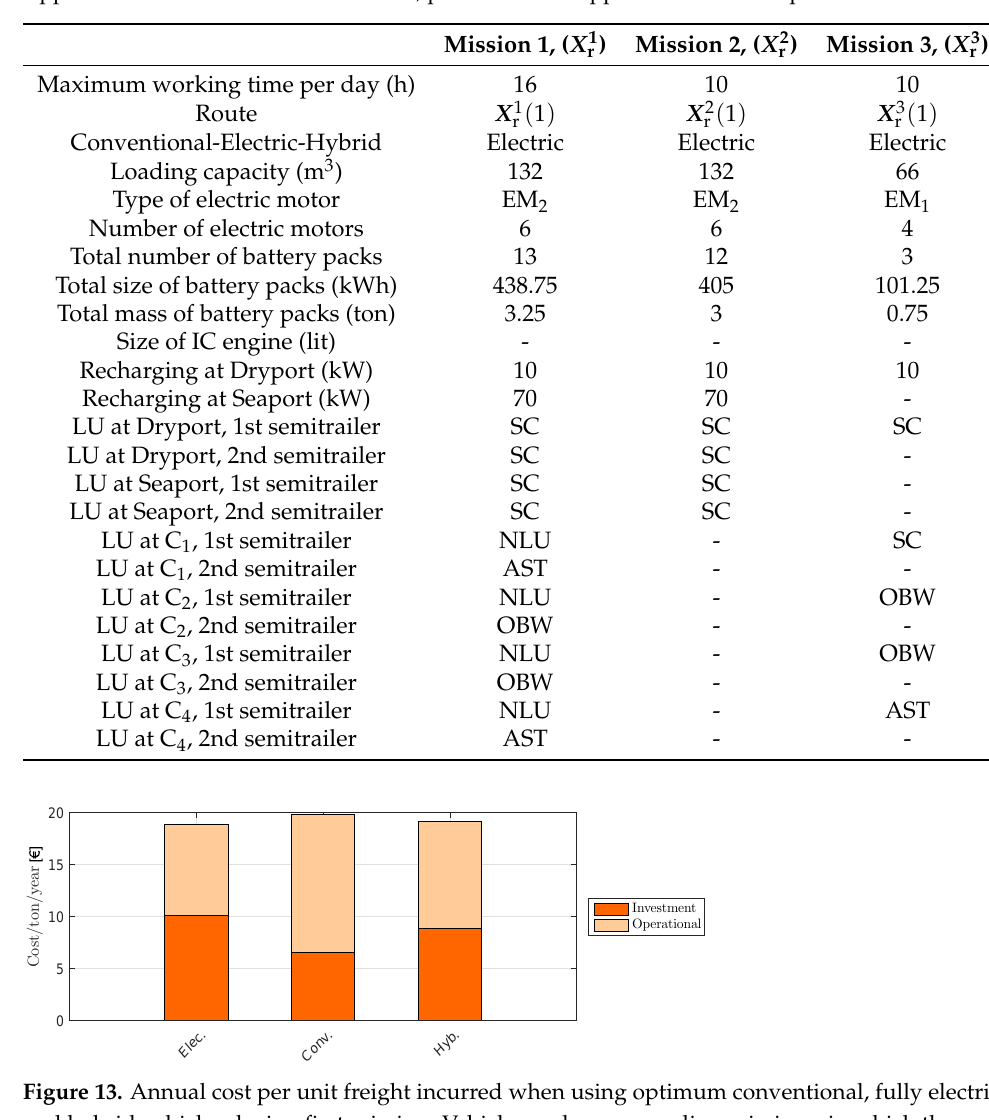
Table 3. Vehicle-hardware, loading–unloading (LU) scheme, and recharging-power designs of three selected optimized vehicles on three missions with the number of vehicles being one on a mission. X i r denotes mission i , that contains different choices of the cyclic routes within mission explained in Appendix D. EM denotes electric motor; please refer to Appendix F for EMs specification.